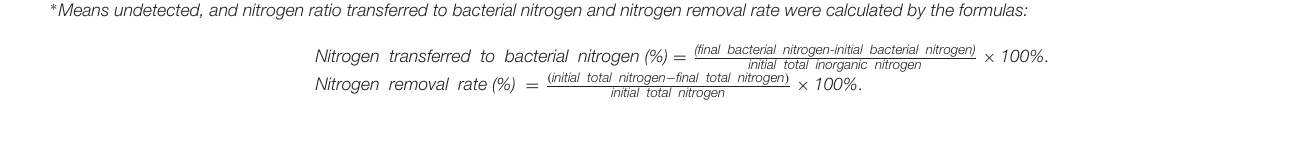
TABLE 2 | Comparison of the denitrification activities of different strains.